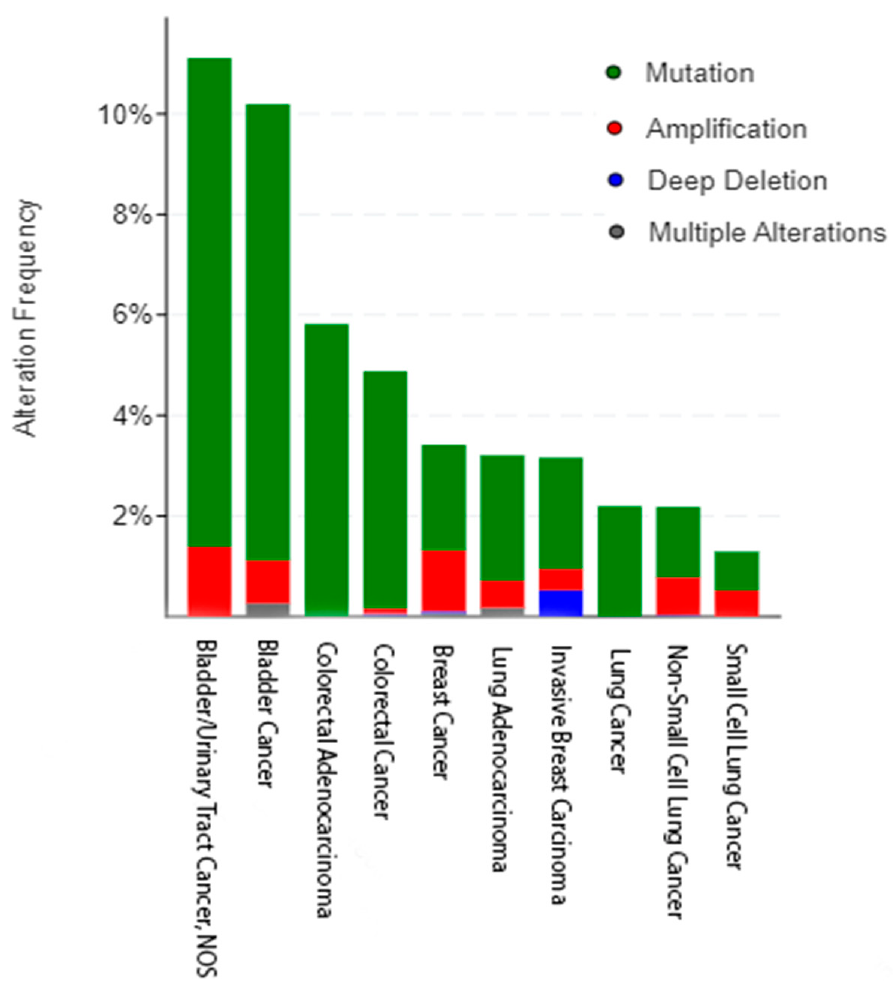
Figure 2. The frequency of HER3 alterations as seen in bladder (n = 2419), breast (n = 8615), colorectal (n = 4453), and lung (n = 7204) cancers across different subtypes and multiple nonredundant studies. Figure rendered using cBioPortal [27,28] .